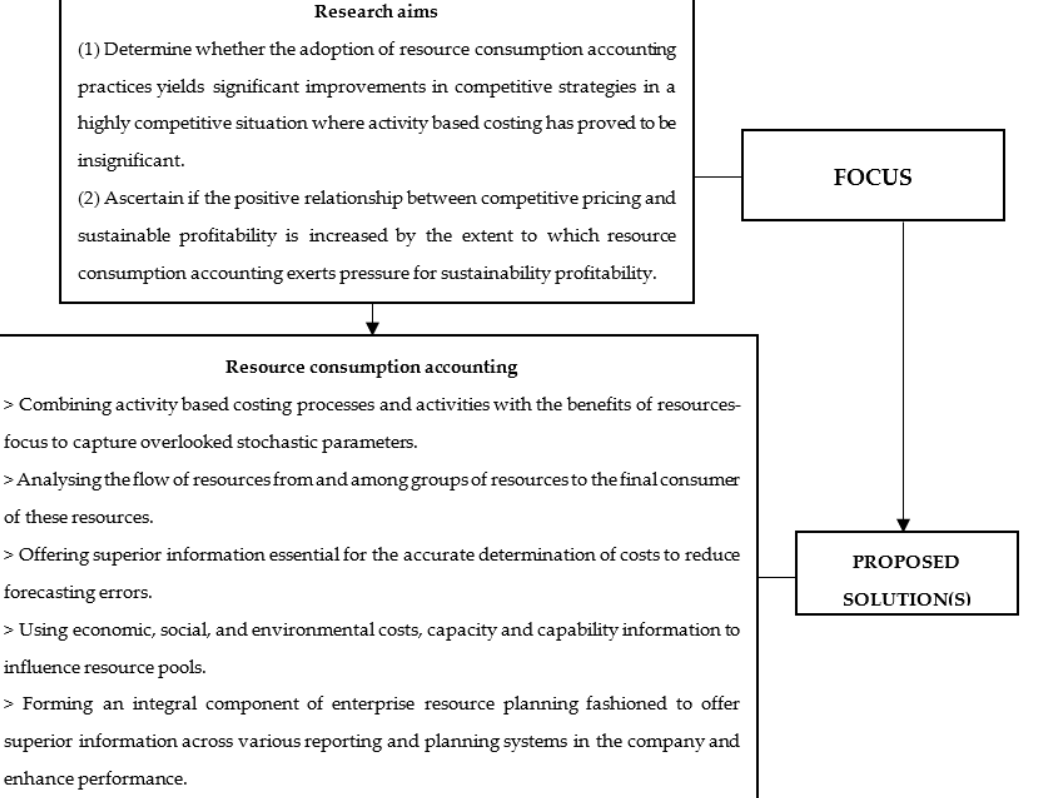
Figure 1. Conceptualization flow chart of the relationship between resource consumption accounting, competitive prices and sustainable profitability.